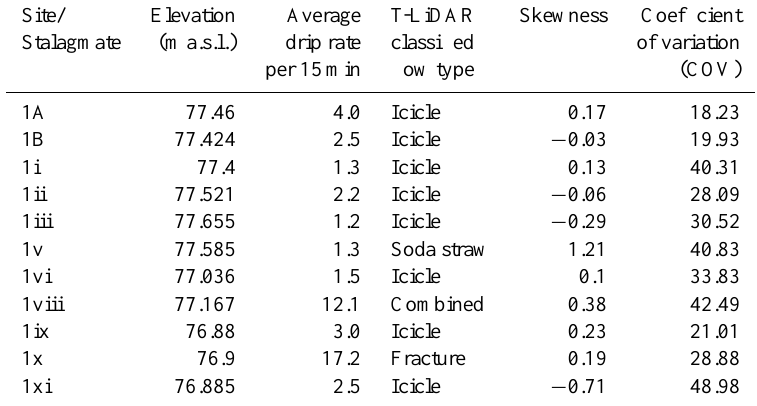
Table 1. Flow classification of chamber 1 drip data.